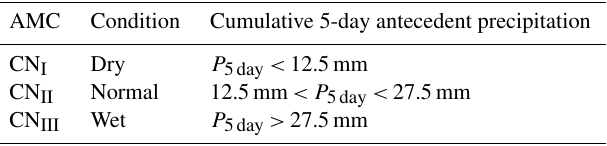
Table A6. Antecedent moisture condition (AMC; based on De- scheemaeker et al.,